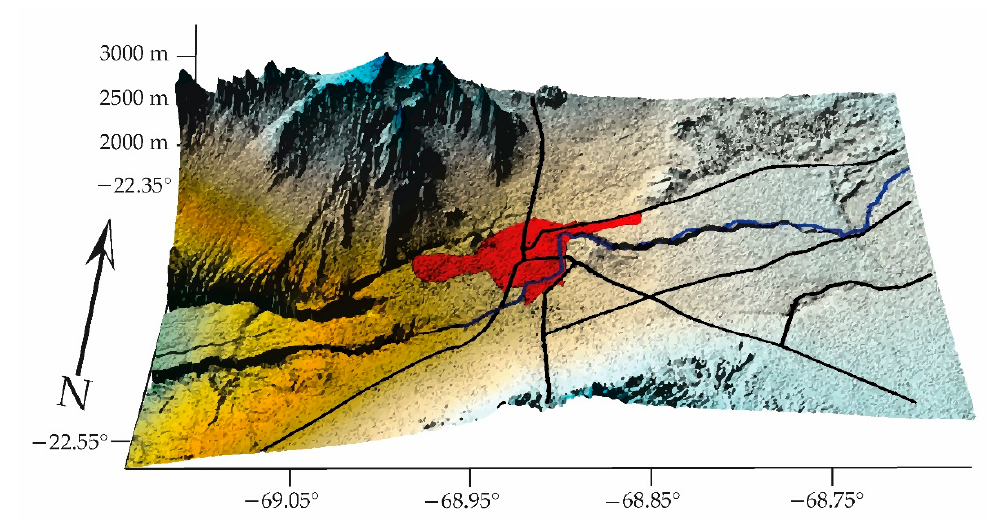
Figure 15. C K, Centro Stat = 1.60, local micrometeorological dominates pollutants (GCS, WGS84). (h), (i) The Tumbaco and Carapungo stations are located in the interior of Quito, mountain cities of Ecuador (Figure 16).